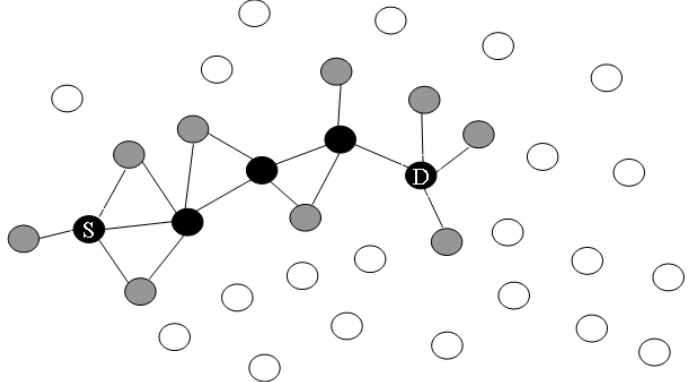
Figure 6. Limitation in sending beacon